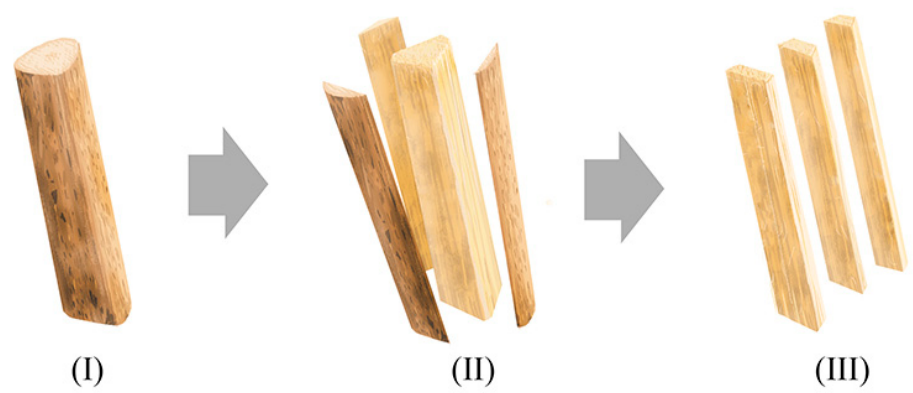
Figure 2. Schematic process of preparing the Buriti foam: ( I ) petiole cutting, ( II ) removal of the bark leaving the Buriti foam exposed, and ( III ) lamination of the Buriti foam.